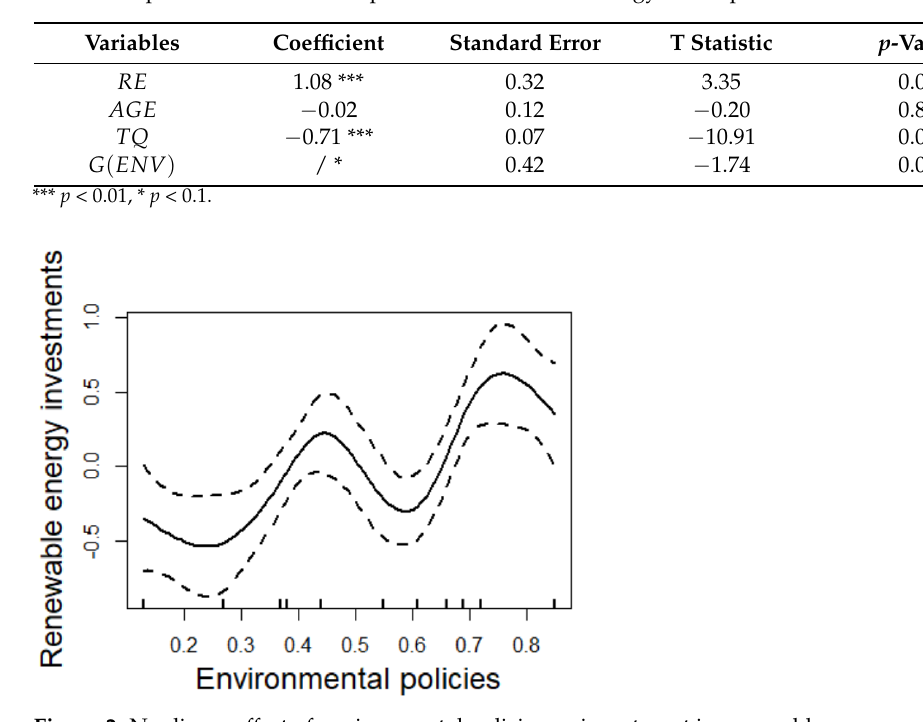
Figure 2. Nonlinear effect of environmental policies on investment in renewable energy enter- prises.